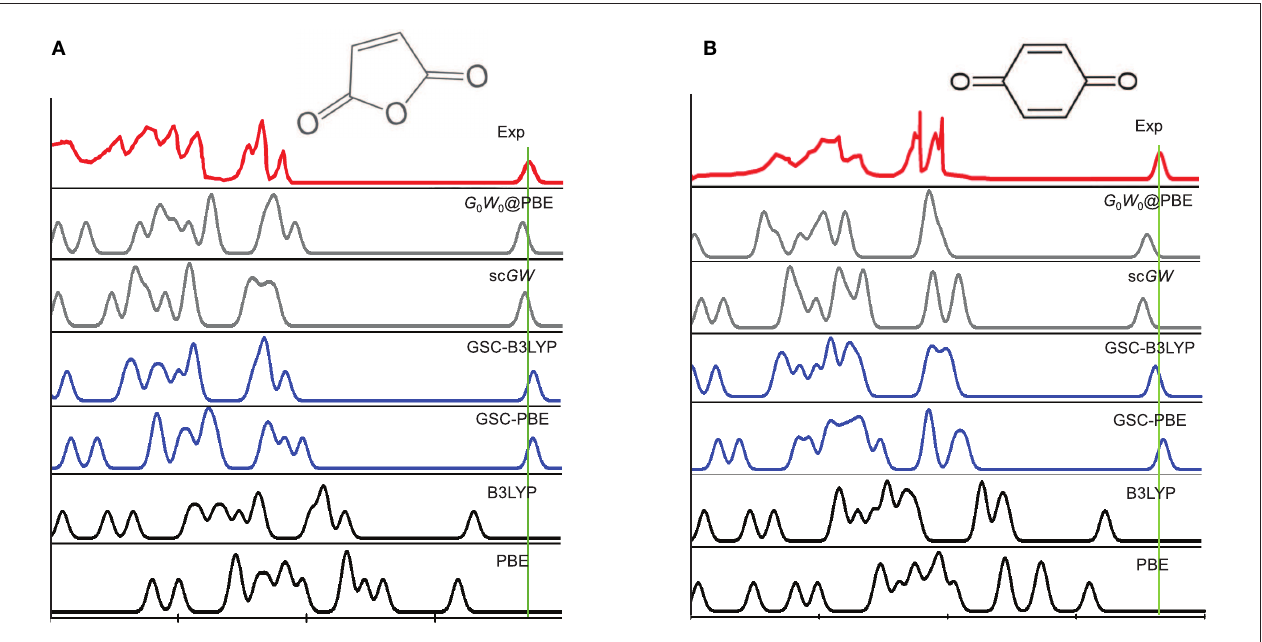
FIGURE 3 | A comparison between the experimental and simulated photoemission spectra (PES) of (A) a maleic anhydride and (B) a benzoquinone. The experimental PES are extracted from Brundle et al. (1972), Knight et al. (2016), with the rightmost quasielectron peak added manually. The quasielectron peak is centered at the experimental EA of the molecule, and is broadened artificially by a Gaussian function with the width of λ = 0.2eV. The simulated PES by using the QE-DFT is explained in the main text, and the results of the self-consistent GW (sc GW ) and non-self-consistent G 0 W 0 methods are extracted from Knight et al. (2016).